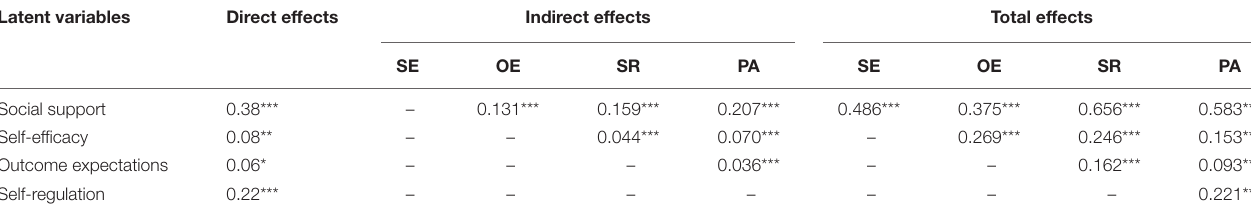
TABLE 2 | The direct, indirect, and total effects of the variables in the social cognitive theory (SCT) model.